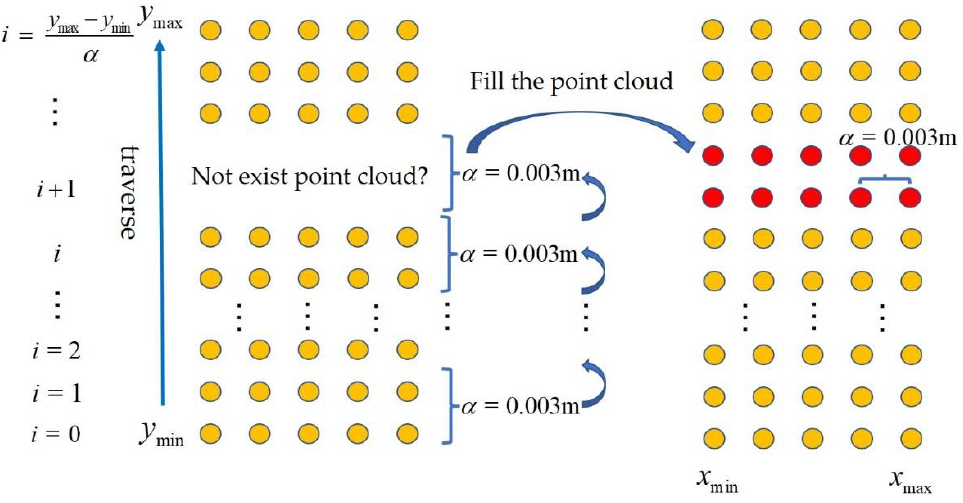
Figure 9. The point cloud filling strategy.